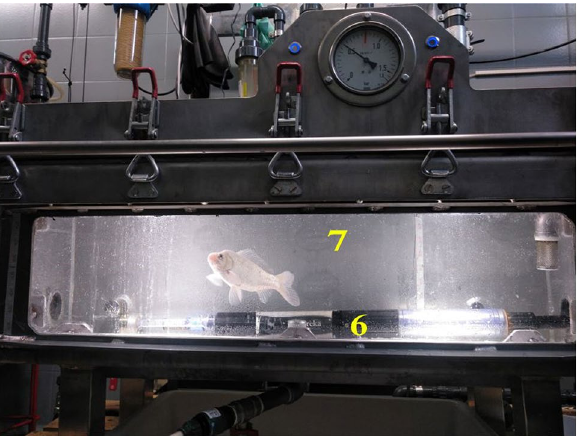
Figure 3. Detail of pressurized aquarium during a fish experiment. TDG and temperature sensor (6). Pressurized aquarium